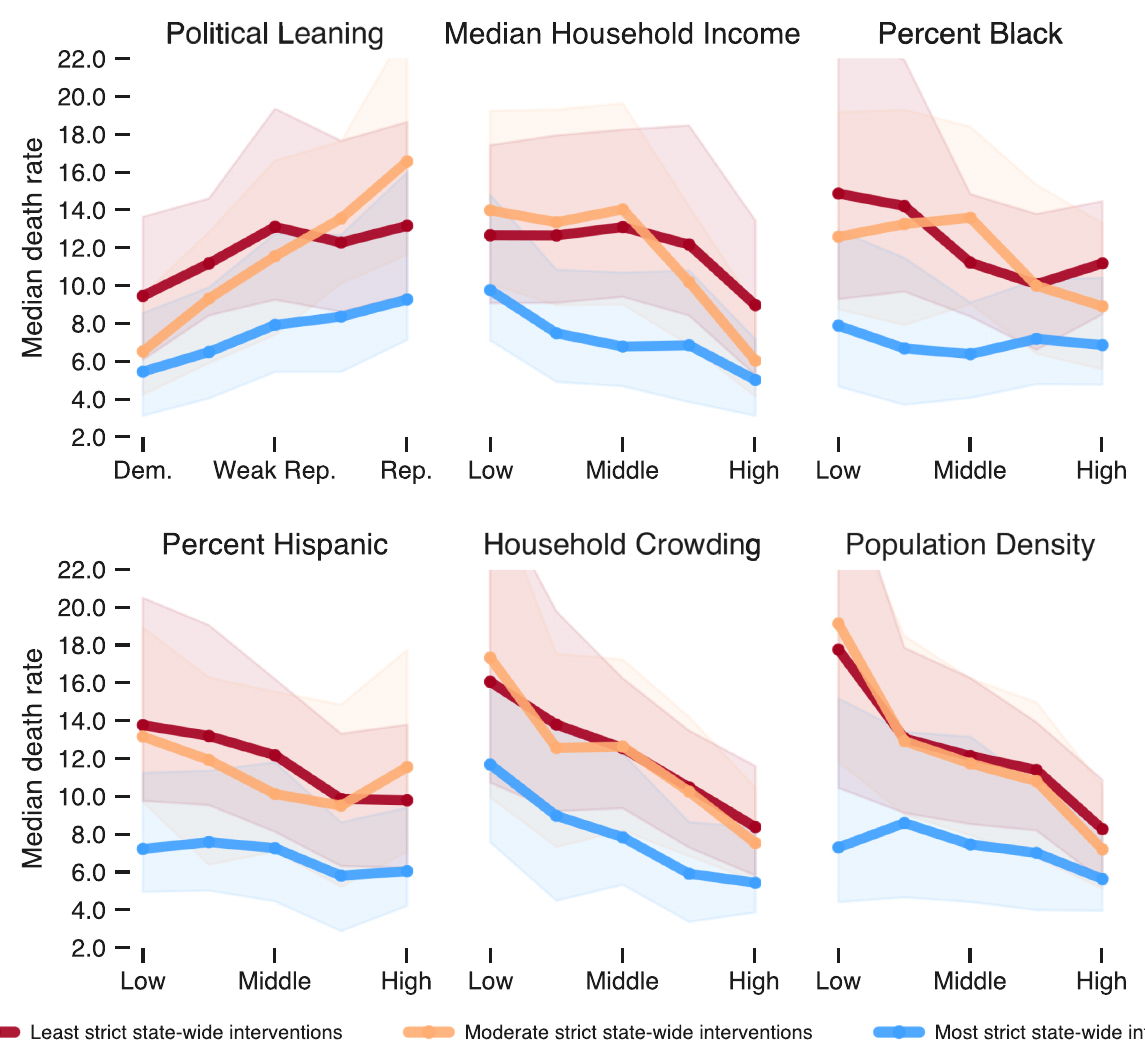
Fig 4. Median death rate in period 3 for each of the six sociodemographic variables broken down by the stringency of state mandates. For each variable, counties are grouped into quintiles. For instance, in the first plot, the leftmost three points represent the median death rate for the 20% of counties with the highest Democratic vote share in lax-, moderate-, and strict-mandate states, respectively. Shaded bands represent the IQR. The differences in each vertically stacked set of three medians are different at the p < 0.001 level (Mood’s median